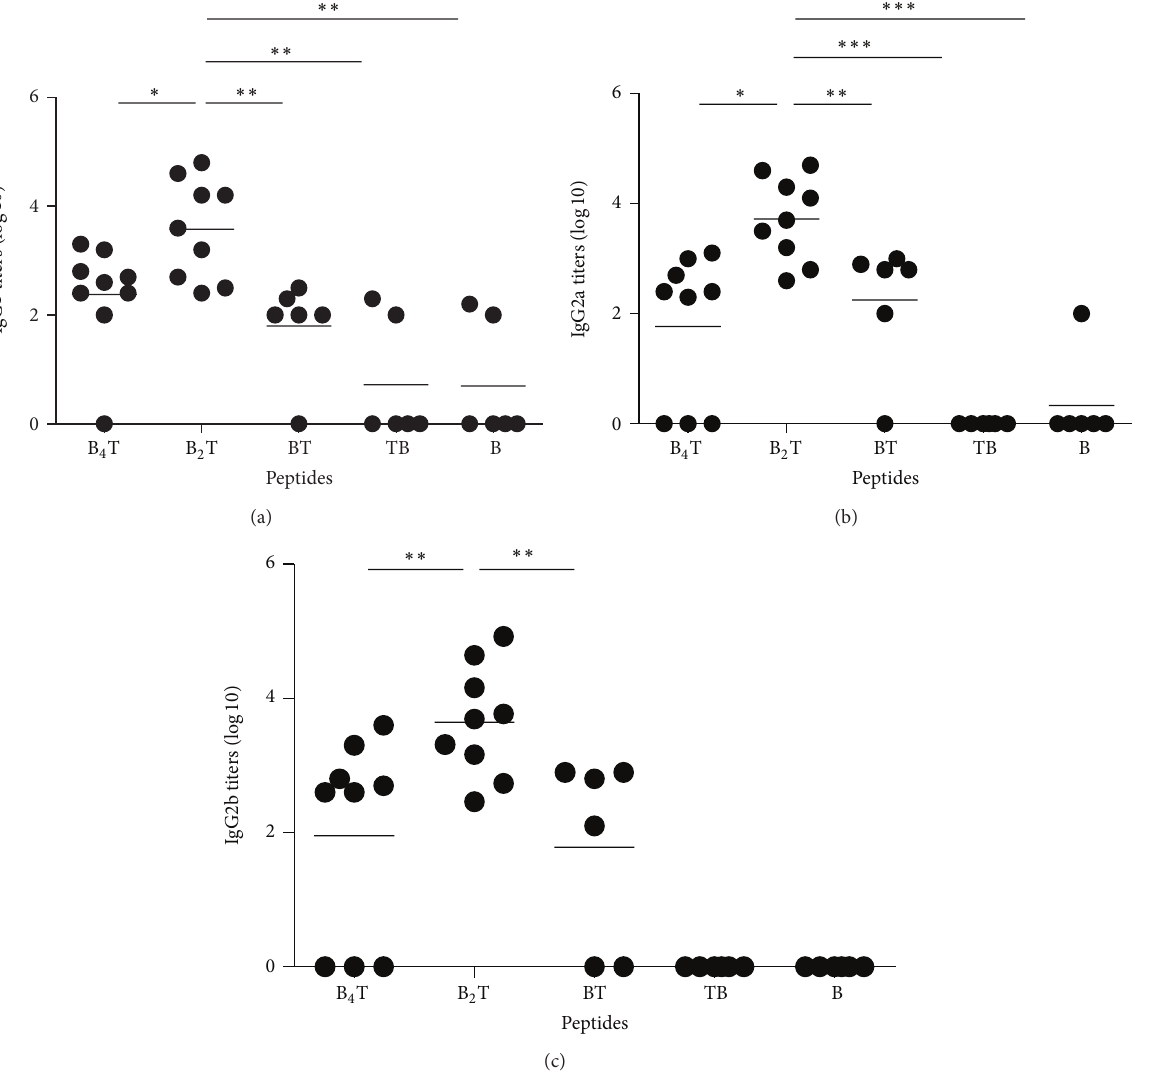
Figure 3: Isotype-specific antibody (IgG1 and IgG2a/G2b) responses to FMDV in sera analyzed by ELISA at day 39 postimmunization. Endpoint titers were expressed as the reciprocal log 10 of serum dilutions giving the absorbance recorded in the control wells (serum collected day 0) plus twice standard deviation. Each symbol represents the value of individual mouse. Horizontal lines indicate the mean value for each group of